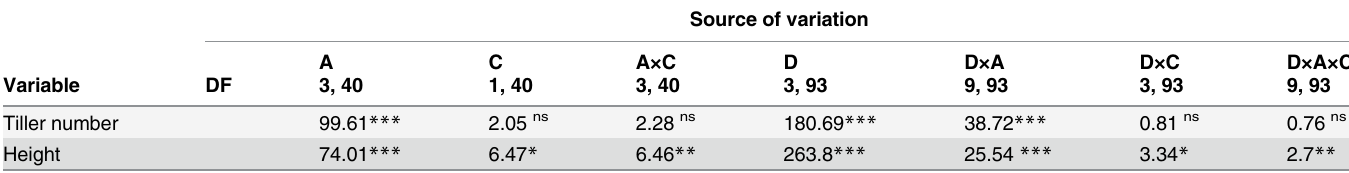
Table 1. Analysis of variance for the effects of alkalinity stress (A), rhizome connection (C) and data (D) on the tiller number and height of subsequent ramets.